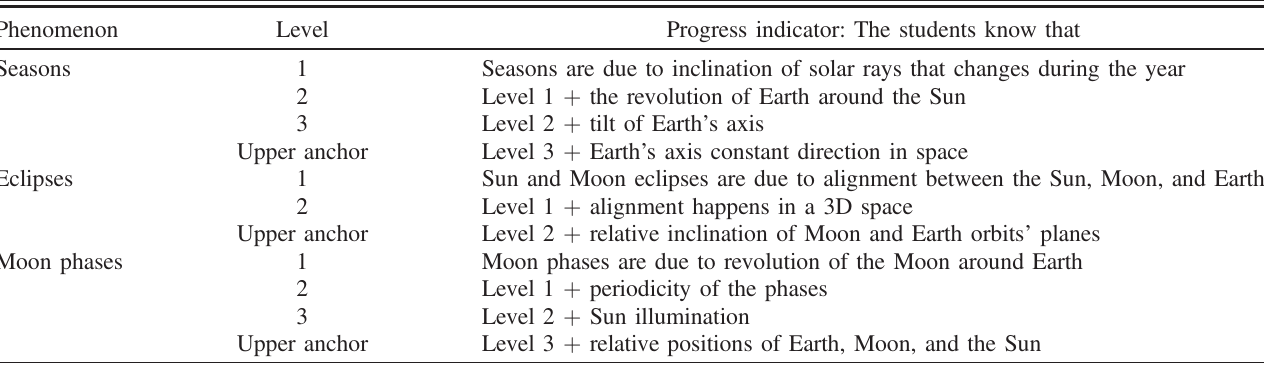
TABLE I. Initial learning progression about change of seasons, eclipses, and Moon phases. Phenomenon Level Progress indicator: The students know